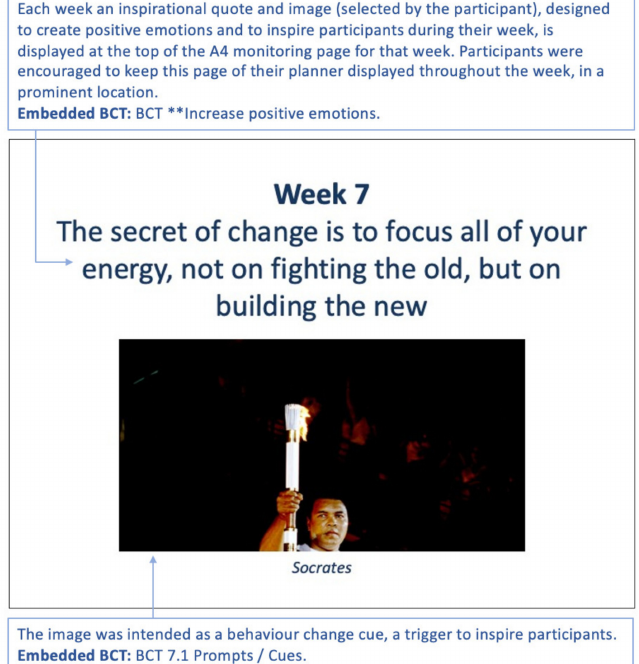
Figure 15. Week 7 inspirational quote and inspirational image selected by the participant. The text in the blue boxes is explanatory text and not part of the planner. BCTs used, refer to the Michie et al. taxonomy [17]. (BCT ** is ‘increase positive emotions’, which is a new BCT scheduled for inclusion in future iterations of the taxonomy.